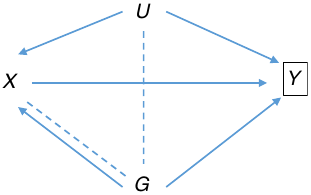
Fig. 2 Directed acyclic graph of association of SNP G with risk factor X conditional on outcome Y . U is as in Fig. 1. For example, X may be body mass index, and Y may be type-2 diabetes, with the study design being case/control or a cohort depleted for cases, such as UK Biobank 17